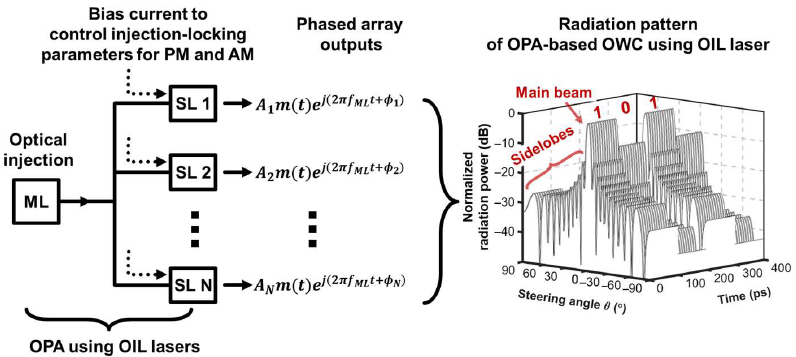
Figure 3. Schematic of OPA-based OWC with OIL semiconductor lasers. ML: master laser, SL: slave laser, OIL laser: optically injection-locked laser, PM: phase modulation, AM: amplitude modulation.